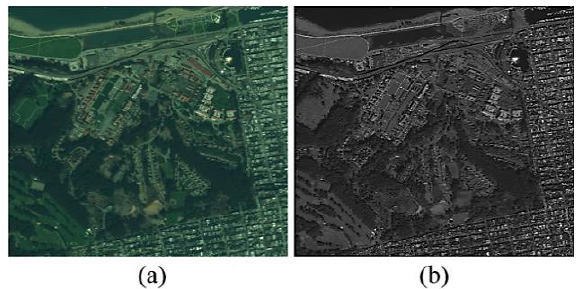
Figure 5. The San Fransisco dataset: (a) multi-spectral image, (b) panchromatic